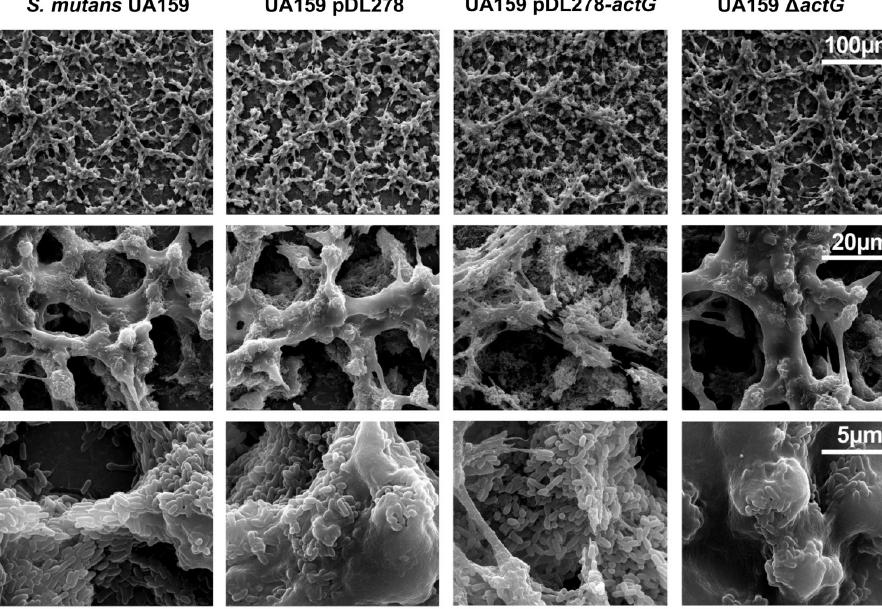
Fig 2. Effect of actG on biofilm architecture of S . mutans . Scanning electron microscopy analysis of the structure of 24-hours-biofilms. Images were captured at 1,000 × , 5,000 × , and 20,000 × magnification. Representative images are shown from at least 5 randomly selected positions of each